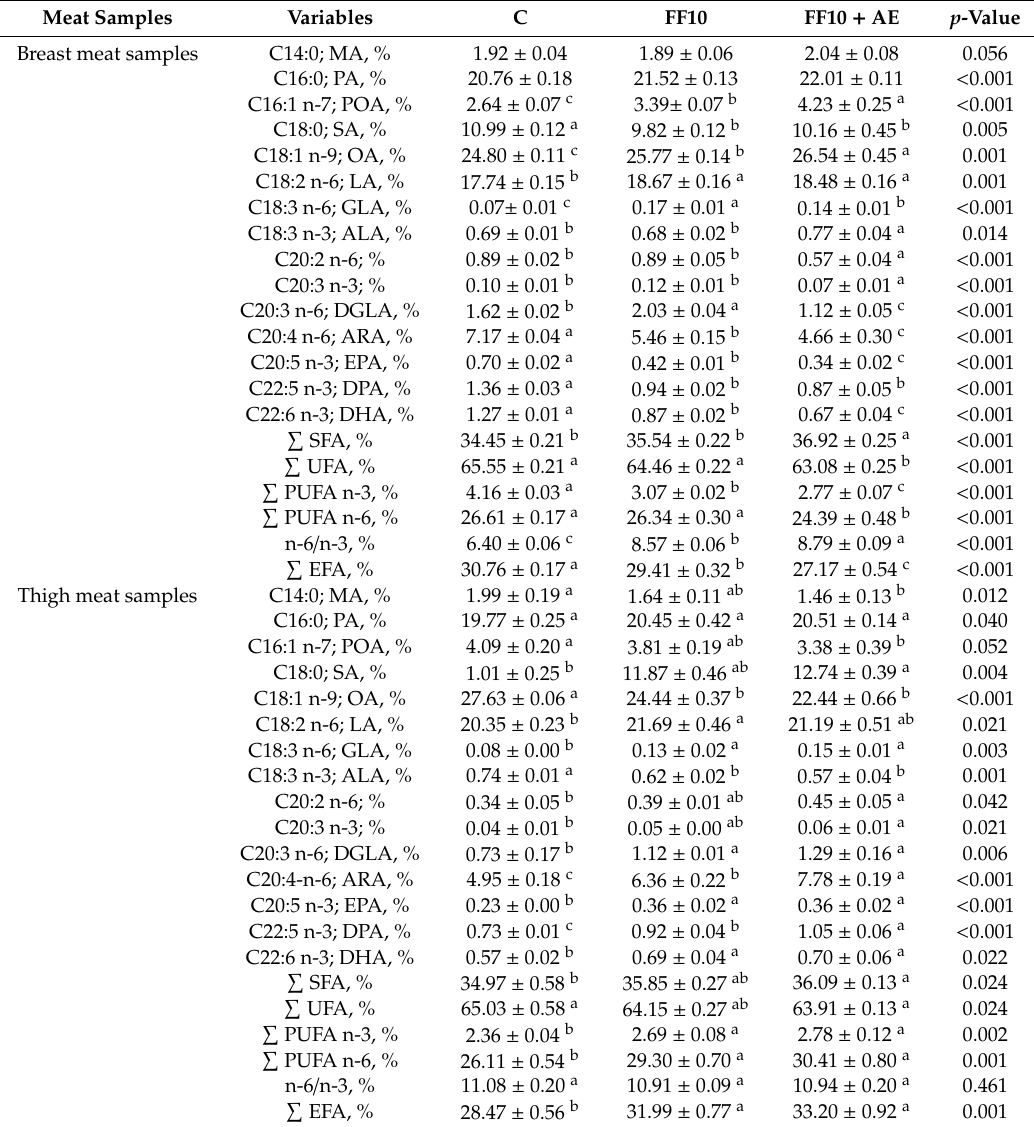
Table 7. Fatty acid profile of breast and thigh meat samples (means ± SD).